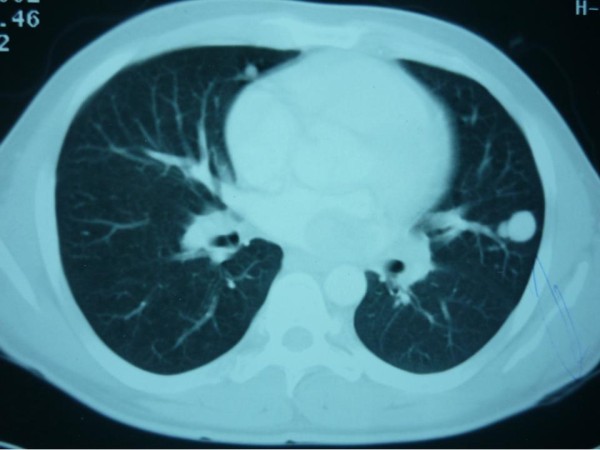
Lung metastasis.